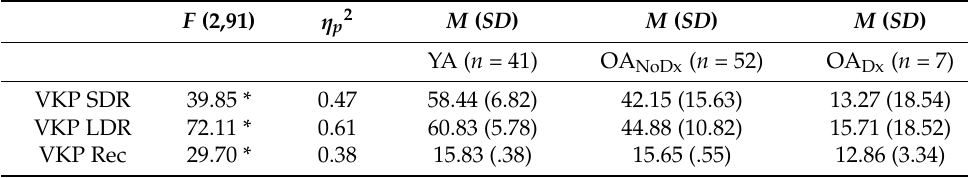
Table 1. Univariate group differences and descriptive statistics on Virtual Kitchen Protocol variables ( n =